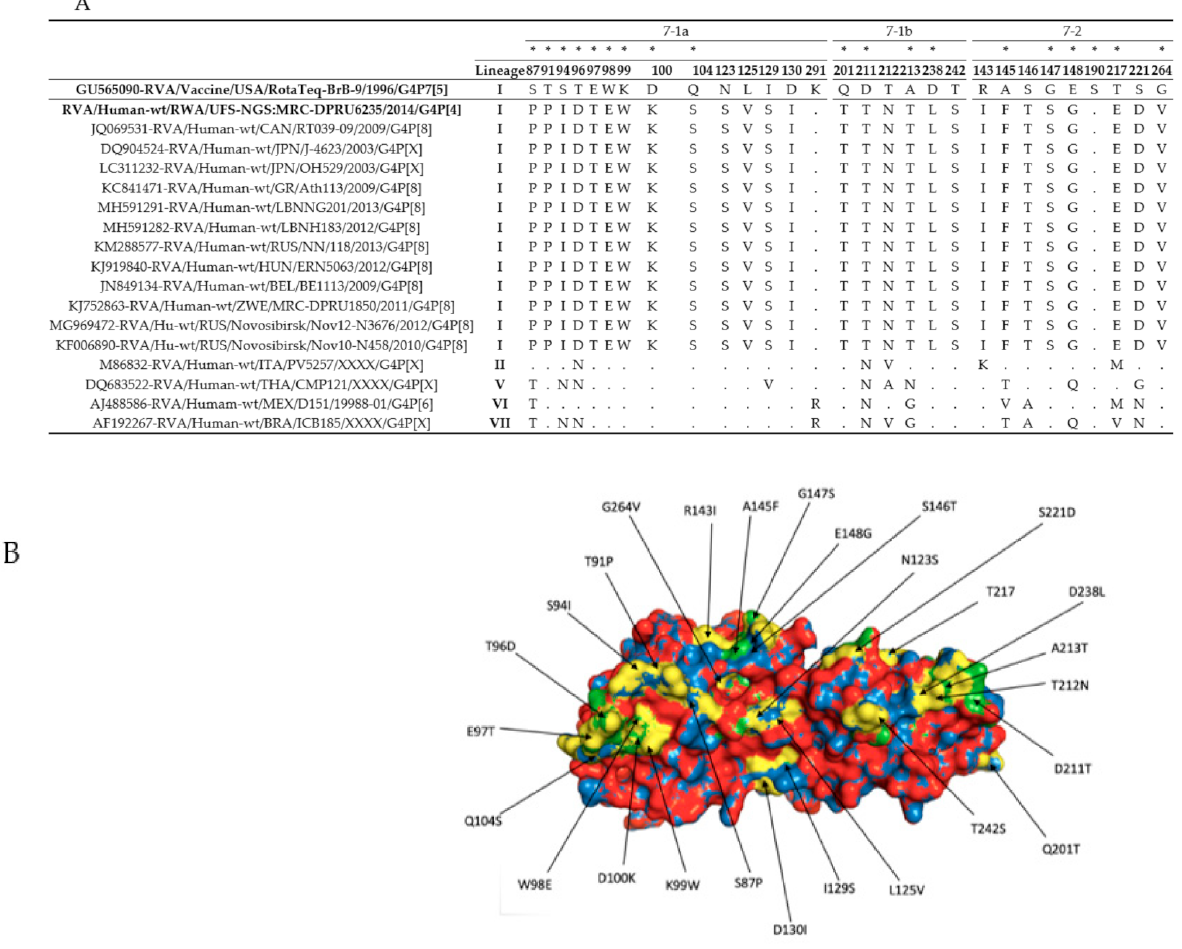
Figure 1. ( A ) The alignment of the G4 VP7 component of the Rotateq vaccine strain and G4 Rwandan study strain based on the three surface exposed epitope regions (7-1a, 7-1b and 7-2). The asterisk (*) represents amino acid position of residues associated with escape neutralization with monoclonal antibodies. ( B ) Surface representation of the VP7 protein. The structure has the root mean square deviation (RMSD) of 0.044 Å. The structure of the RotaTeq ® vaccine strain is represented with the red colour and overlapped with the structure of the Rwandan study strain indicated with the blue colour. The green colour represents the amino acid changes observed on the Rwandan study strain as compared to the RotaTeq ® vaccine strain